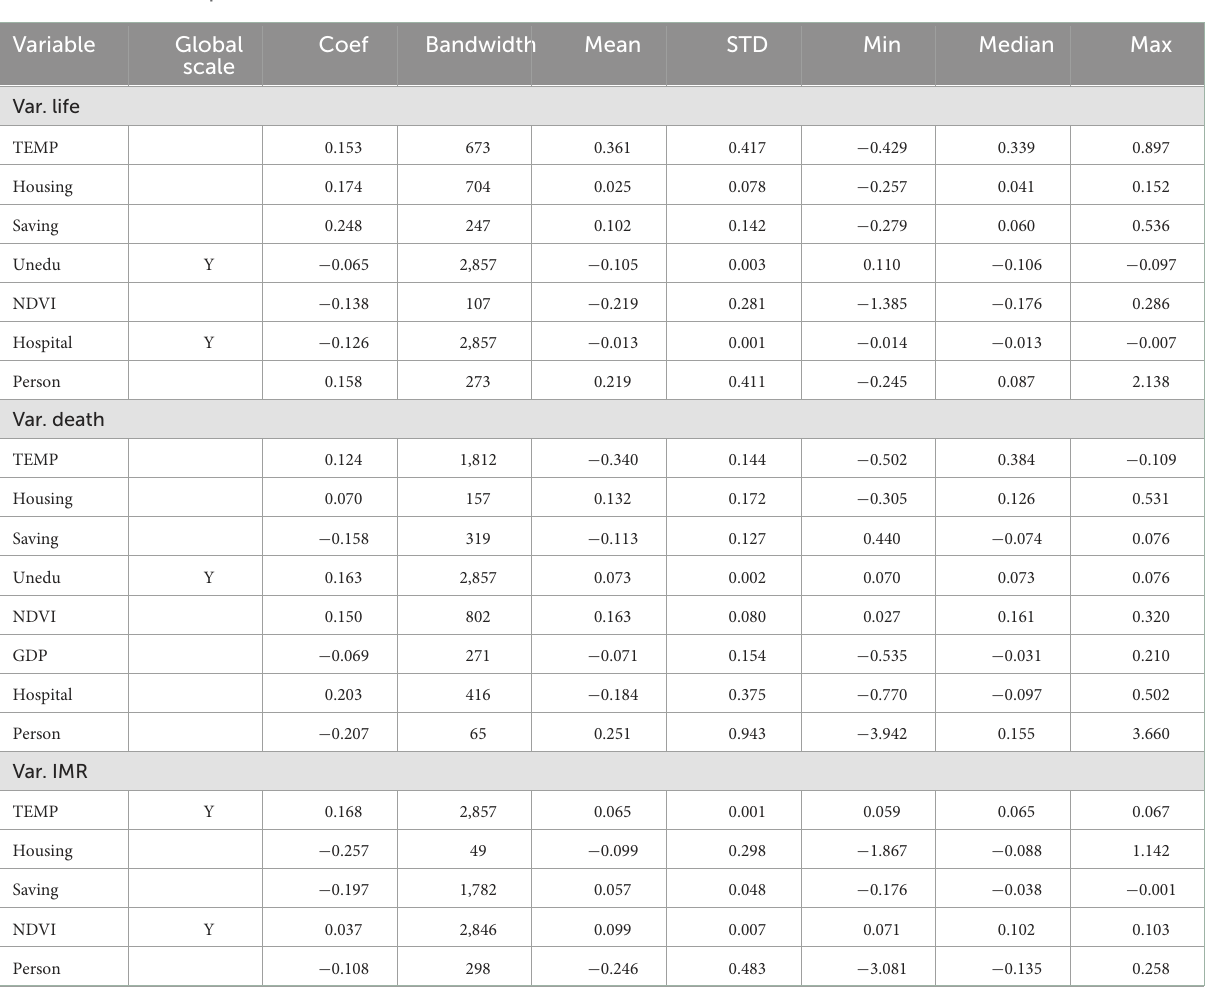
TABLE 7 Statistical description of MGWR coefficients,